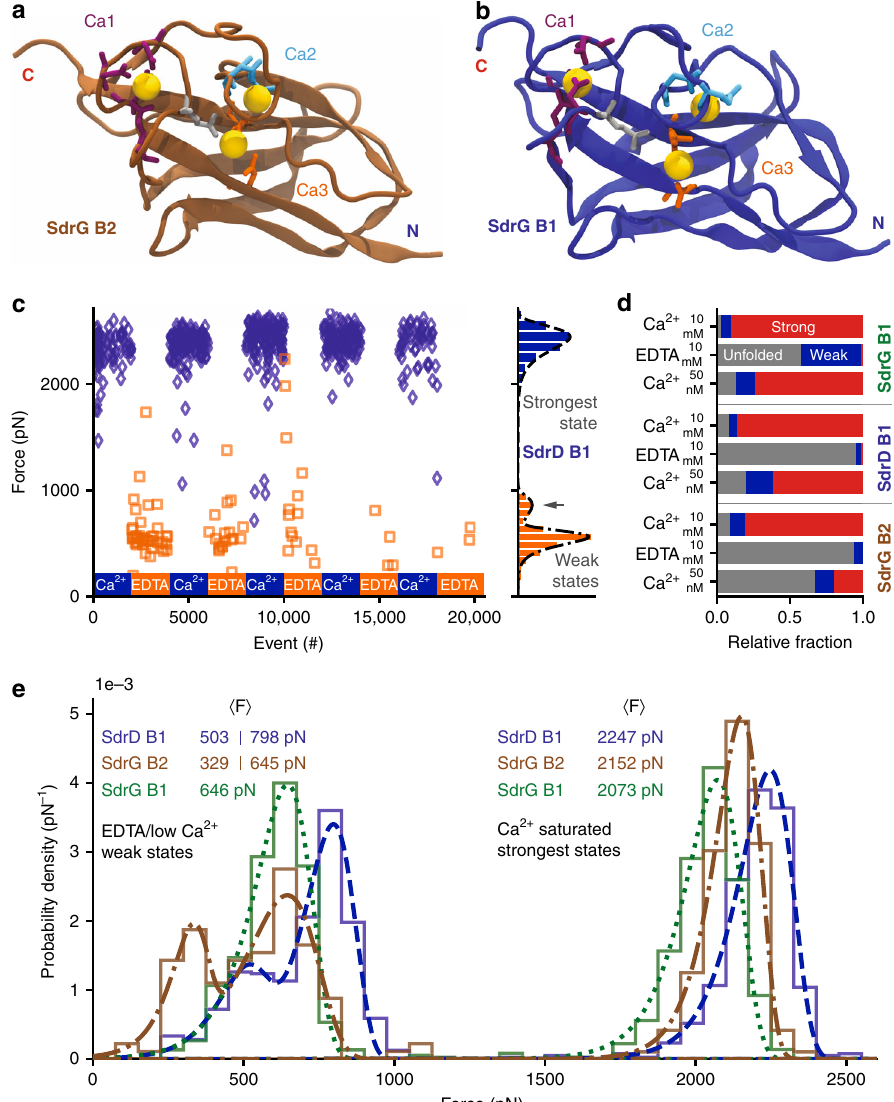
Fig. 4 SdrG B2 and SdrD B1 are even stronger than SdrG B1 and have different Ca 2 + af fi nities. a Equilibrated homology model of SdrG B2 (brown) with Ca 2 + (yellow) binding loops one to three marked, coordinating amino-acid side chains shown as sticks (coloring as in Fig. 3a). b Equilibrated crystal structure of SdrD B1 (blue, PDB 4JDZ). c Cycling of SdrD B1 between 10 mM Ca 2 + and 10 mM EDTA, a strong state in Ca 2 + over 2000pN emerges. The weak state is bimodal peaking at ~ 550 pN and ~ 850 pN (gray arrow), fi t with a superposition of two BE p(F) functions (see methods). Very few unfolding events appear in 10 mM EDTA, thus the Ca 2 + -chelation must be suf fi cient to completely unfold most SdrD B1 domains. The strong state is also bimodal in low Ca 2 + conditions see Supplementary Fig. 8. d Relative fraction of states in different buffers: 10 mM Ca 2 + , 10 mM EDTA, and 50 nM Ca 2 + (applied after 10 mM EDTA) for SdrG B1, B2 and SdrD B1 compared with a single cantilever: no unfolding event (unfolded protein, gray), weak state (< 1000 pN, blue), strong state (> 1500 pN, red). Almost all SdrD B1 and SdrG B2 domains are unfolded in EDTA and only a fraction refolds in low Ca 2 + . SdrG B2 has the lowest af fi nity for Ca 2 + as it shows the least folded events in low Ca 2 + . e Comparison of relative unfolding forces of all B domains at 1.6 µ m s − 1 with a single cantilever. The strongest state of SdrD B1 (blue, dashed line) is the most mechanostable, followed by SdrG B2 (brown, dash-dotted line), then SdrG B1 (green, dotted line). The weak states of SdrD B1 and SdrG B2 are bimodal and best described with a superposition of two BE fi ts, whereas SdrG B1